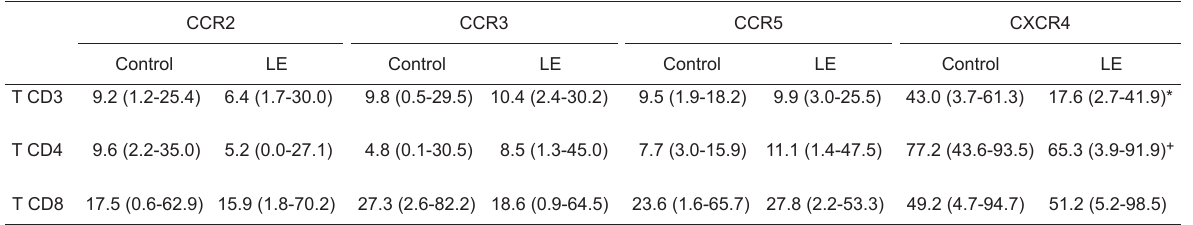
Table 1. Analysis of lymphocyte (T CD3, CD4, and CD8) expression of CCR2, CCR3, CCR5, and CXCR4 chemokine receptors in healthy controls (N = 20) and leprosy patients (LE; N = 21).